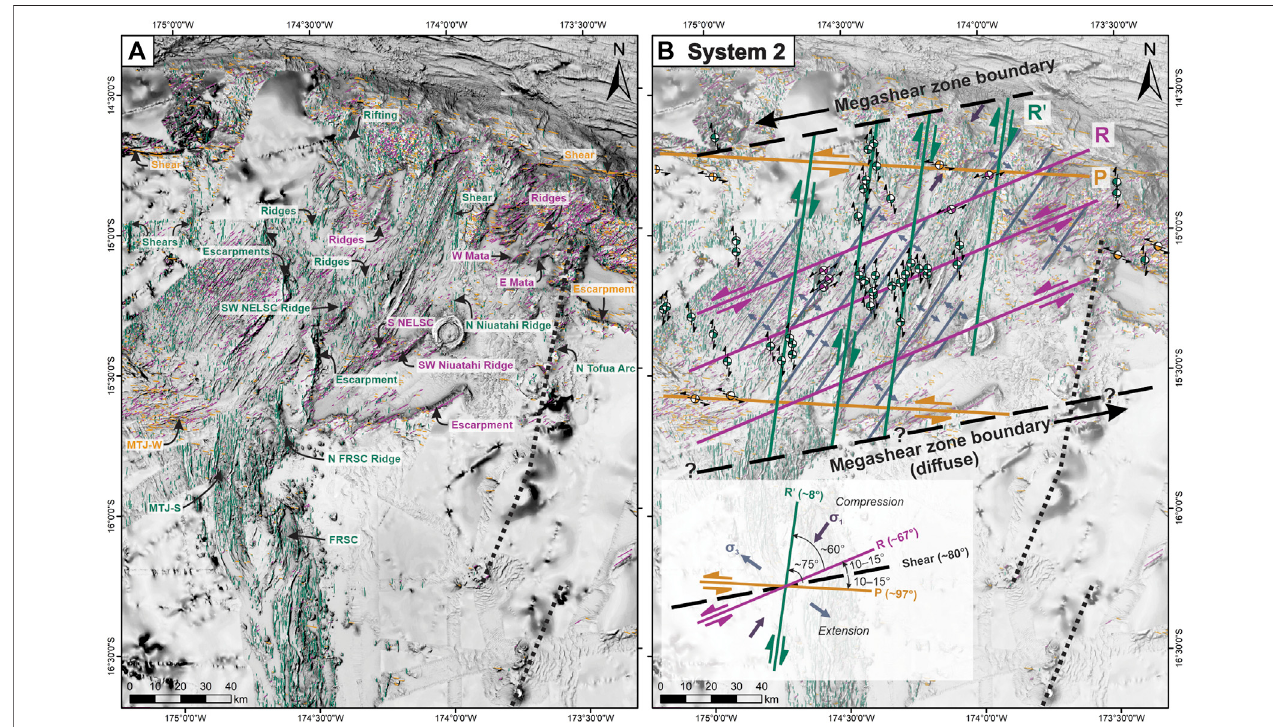
FIGURE 10 | The second set of structures overlain on TTS-shaded bathymetry: (A) lineaments include N-trending ( ∼ 8 ° ), ENE-trending ( ∼ 67 ° ), and W-trending ( ∼ 97 ° ),and areassociatedwithnumerousmajor structural and volcanicfeaturesinthemap area(annotations asin Figure2 ); (B) generalized megashear mechanism for this set of structures (Riedels System 2), with shear zone boundaries rotated counter-clockwise to ∼ 80 ° , dominated by N-trending R ʹ -shears (R-lateral). Extension associated with σ 3 is offset by R-shears (L-lateral) and is also associated with large volcanic ridges across the map. Active seismicity (CMTs) dominates the central map area closer to the arc, extending south to a diffuse boundary (dashed line). Bathymetric compilation as in Figure 3 .